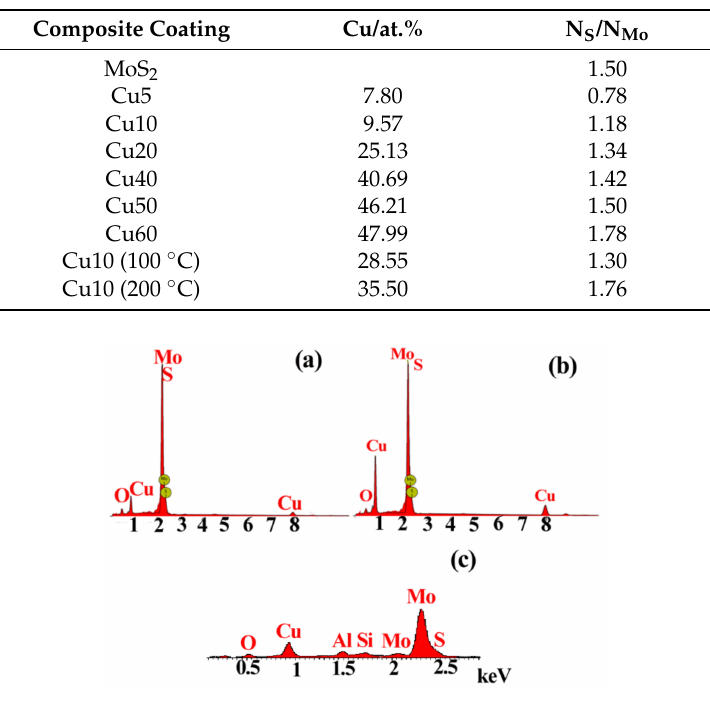
Figure 3. EDS spectrum corresponding to the ( a ) Cu10; ( b ) Cu20; and ( c ) Cu5Al5.